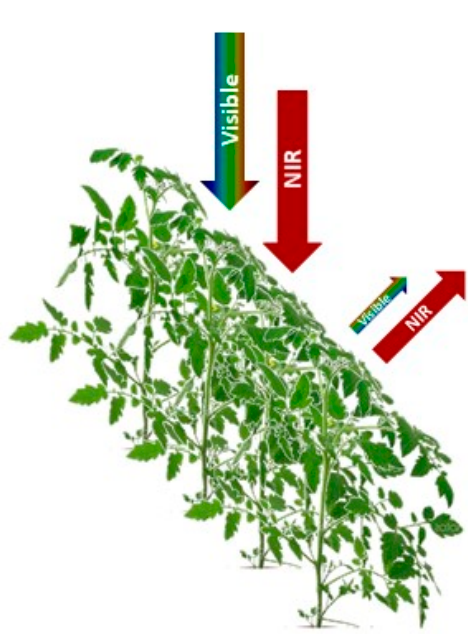
Figure 3. Schematic representation of the functioning of active canopy reflectance sensors. Differential reflectance of visible and near-infra red radiation (NIR) is used to calculate vegetation indices.